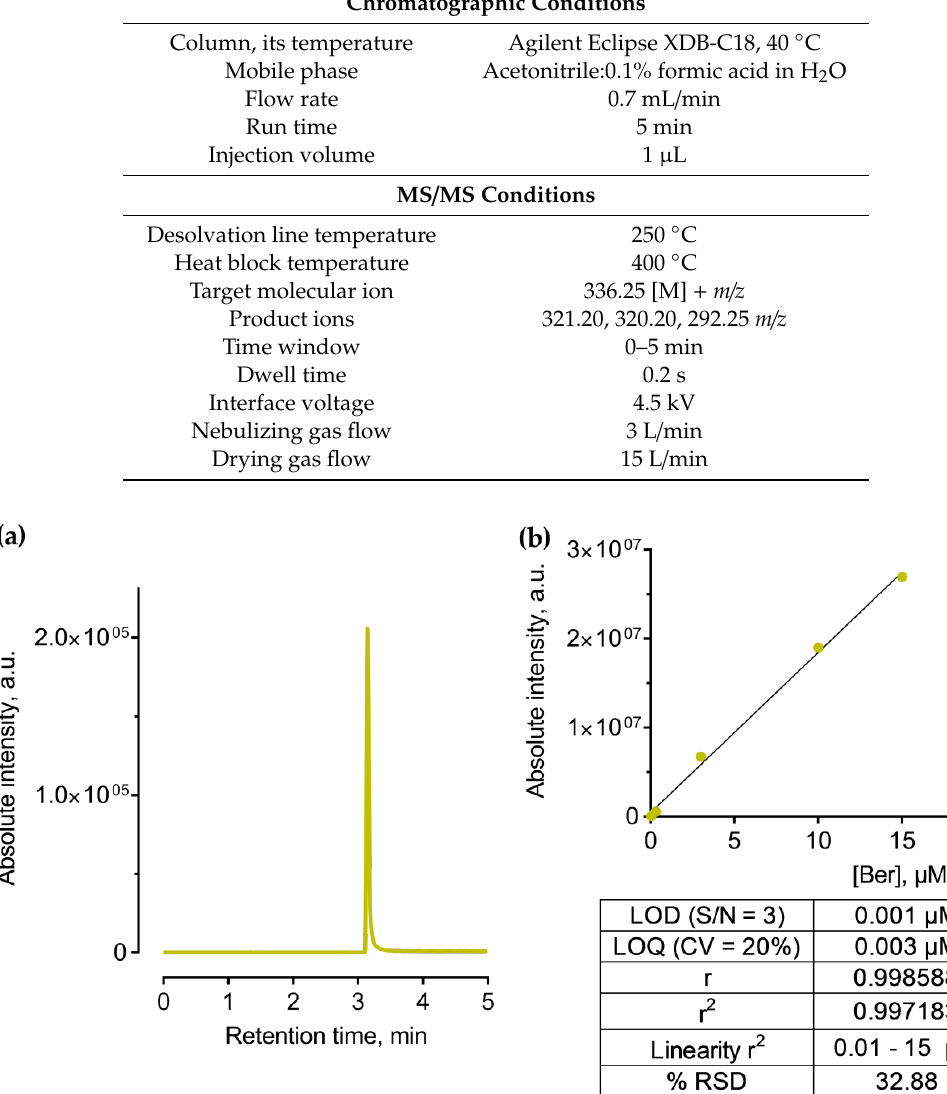
Figure 2. Data of the developed HPLC-ESI-MS method for Ber detection and quantification: representative MRM-chromatogram of Ber ( a ) and a calibration curve with the method’s performance characteristics used for drug content quantification: LOD—limit of detection, S / N—signal / noise ratio, LOQ—limit of quantitation, RSD—relative standard deviation ( b ). Table 1. HPLC-ESI-MS/MS conditions for analysis of Ber.